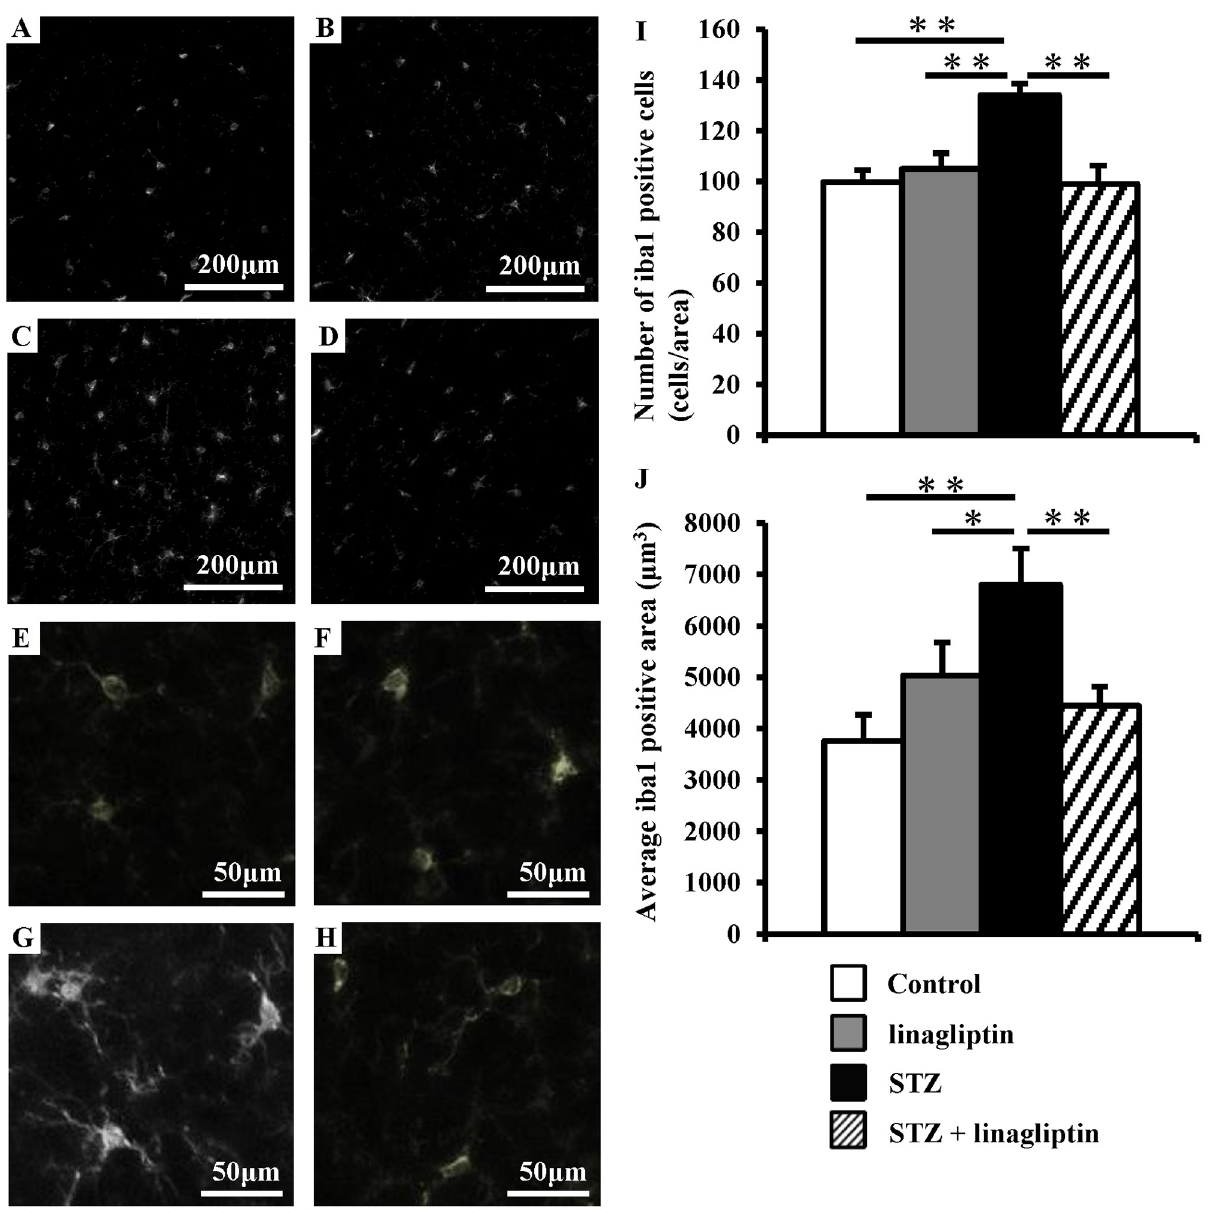
Fig 4. Effect of linagliptin on brain microglia in diabetic mice. Cerebral cortex sections were immunostained with anti-Iba1 antibodies. (A, E) Control mice, (B, F) linagliptin-treated control mice, (C, G) diabetic mice and (D, H) linagliptin-treated diabetic mice. The cell number (I) and body area (J) of Iba1-positive cells in the brains. Bars represent means ± SEM (n = 8). � P < 0.05, �� P < 0.01.